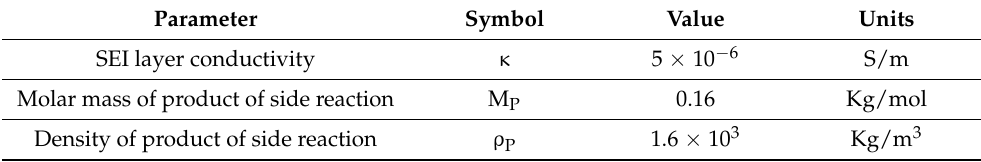
Table 2. Assumed parameters of solvent reduction side reaction.